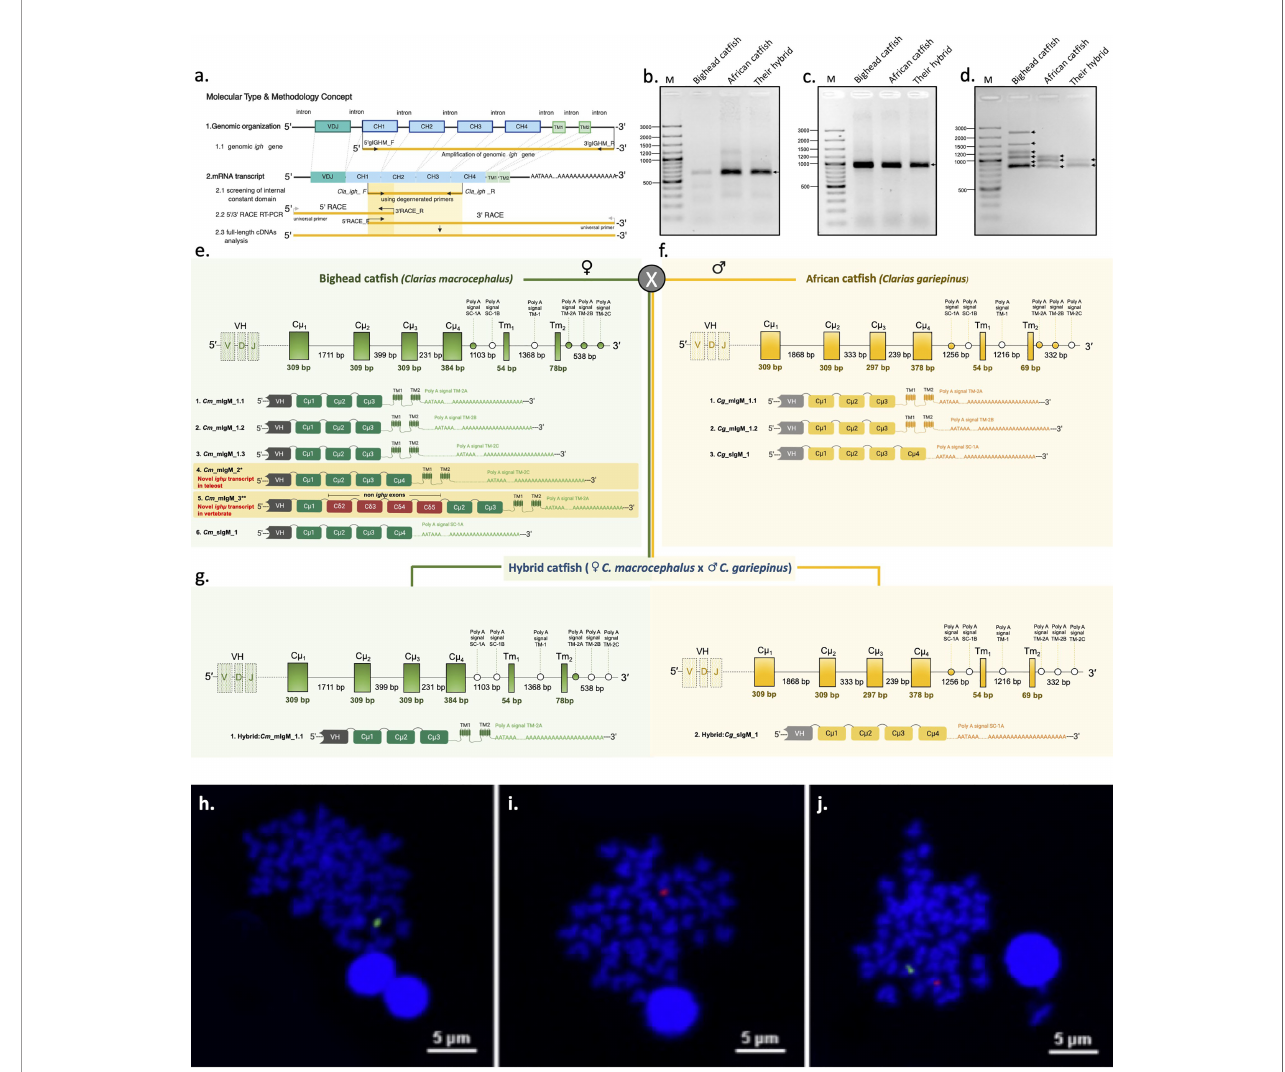
FIGURE 1 | Representation of the genomic organization and splicing patterns of Igh m in teleosts and cat fi sh. Igh m generally encodes a VH domain, four constant (C m 1 to C m 4 ) domains and two transmembrane domains. For full-length cDNA Igh m transcripts in bighead cat fi sh, North African cat fi sh and their hybrid cat fi sh, three major molecular techniques were performed (A) . Patterns of PCR ampli fi cation products, 5 ’ RACE PCR (B) , internal constant domain (C) , and 3